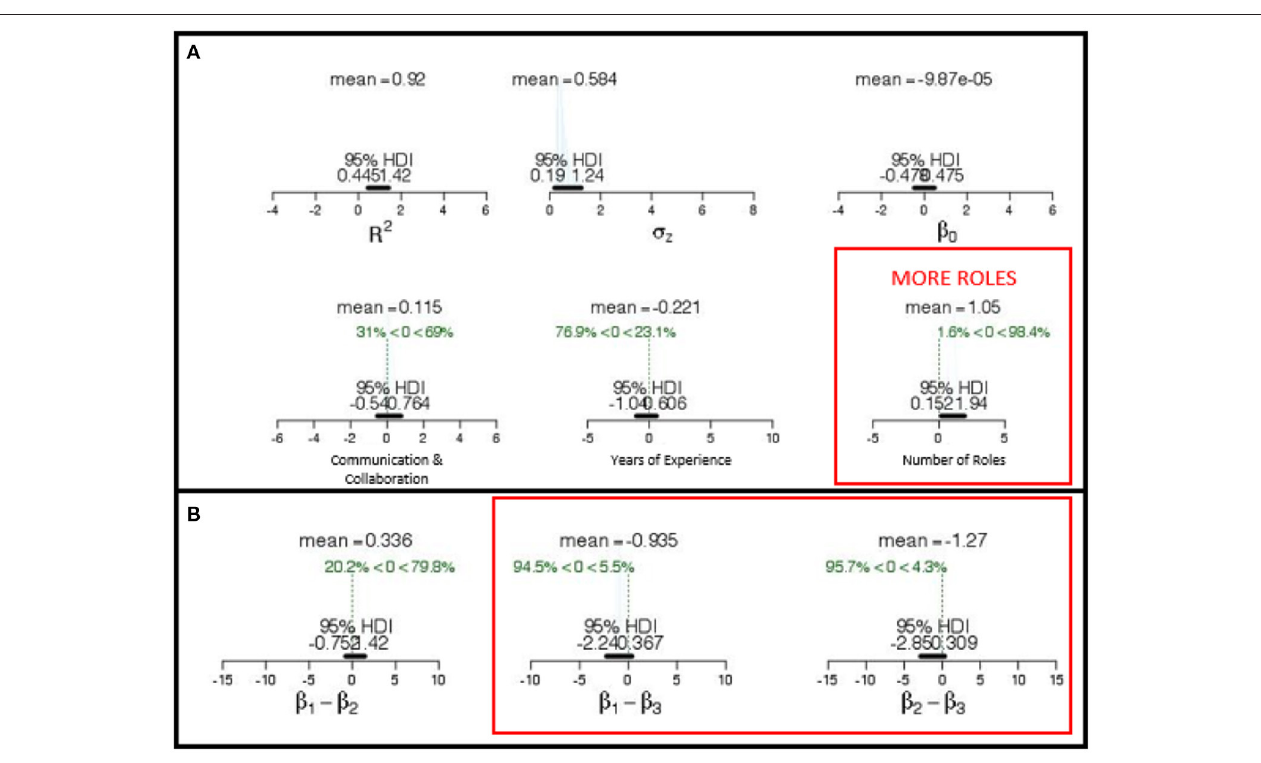
FIGURE 7 | (A) Posterior distributions of regression parameters for Model 1 predicting Maintaining Services score with β 1 (Communication & Collaboration Factor), β 2 (Years Experience), and β 3 (Number of Roles) as predictors of team performance. Strong predictors (Number of Roles) indicated by red type. (B) Posterior distributions of difference among parameters indicate unique predictive quality of β 1 , β 2 and β 3 to Maintaining Services scored